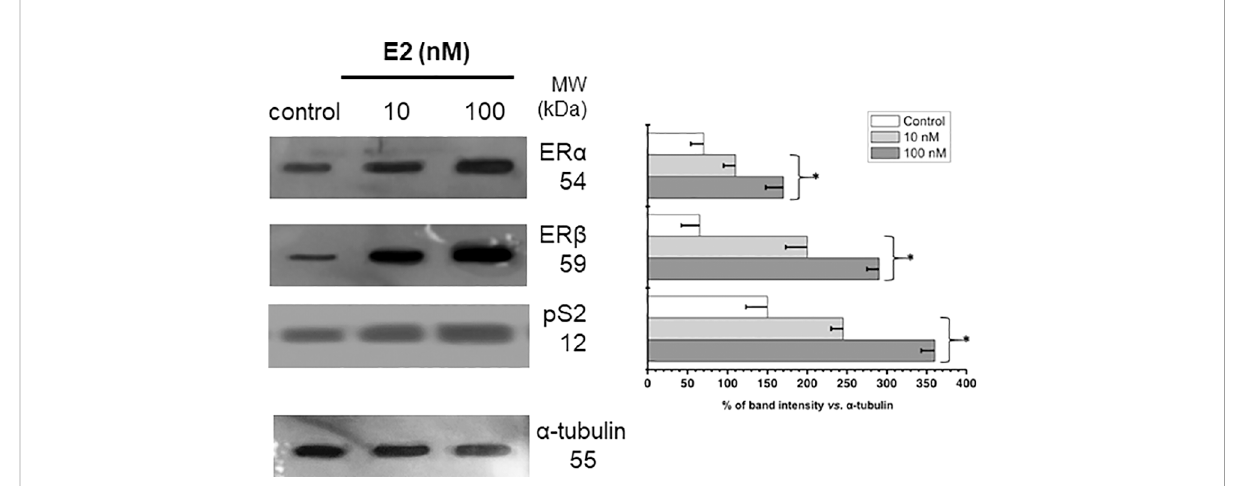
FIGURE 2 Effect of E2 on the contents of ERs and PS2 in MCF-7 MCTS. Histograms represent a double normalization against a -tubulin. Data shown represent the mean ± S.D. of at least three different preparations. * P <0.05 vs. control (non-treated cells).